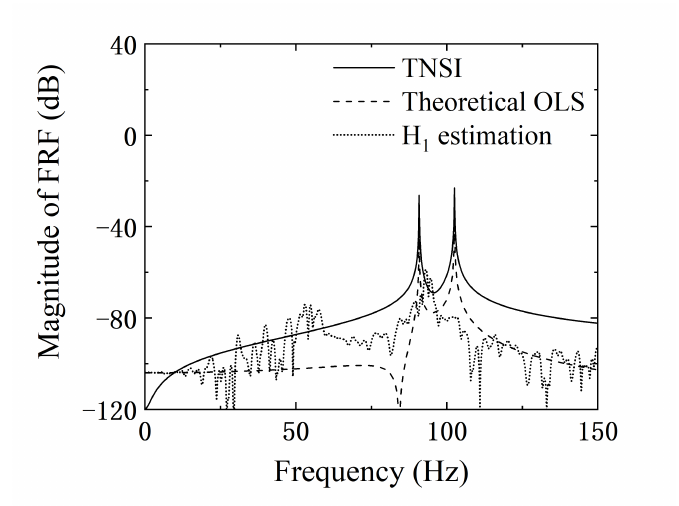
Figure 10. The estimated frequency response function (FRF) ( H 11 ) of overlying linear system (OLS) using time-domain nonlinear subspace identification (TNSI) method.